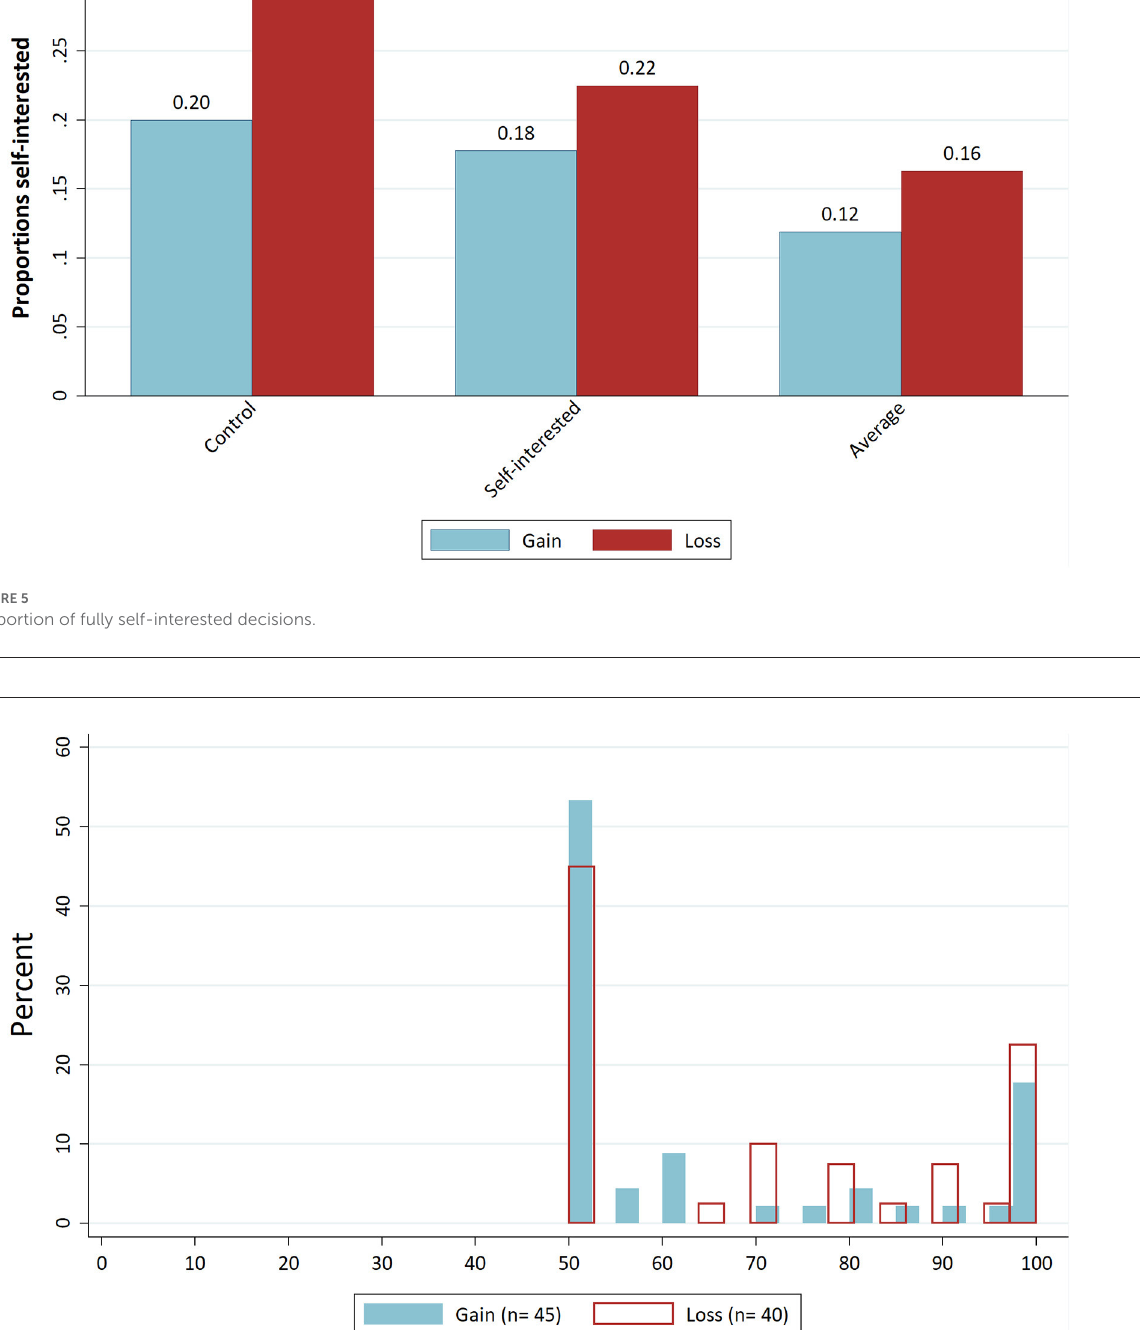
people tend to follow what others do. From experimental studies Bicchieri and Xiao (2009) and Lindström et al. (2018), we know that empirical expectations of how others will behave in a given